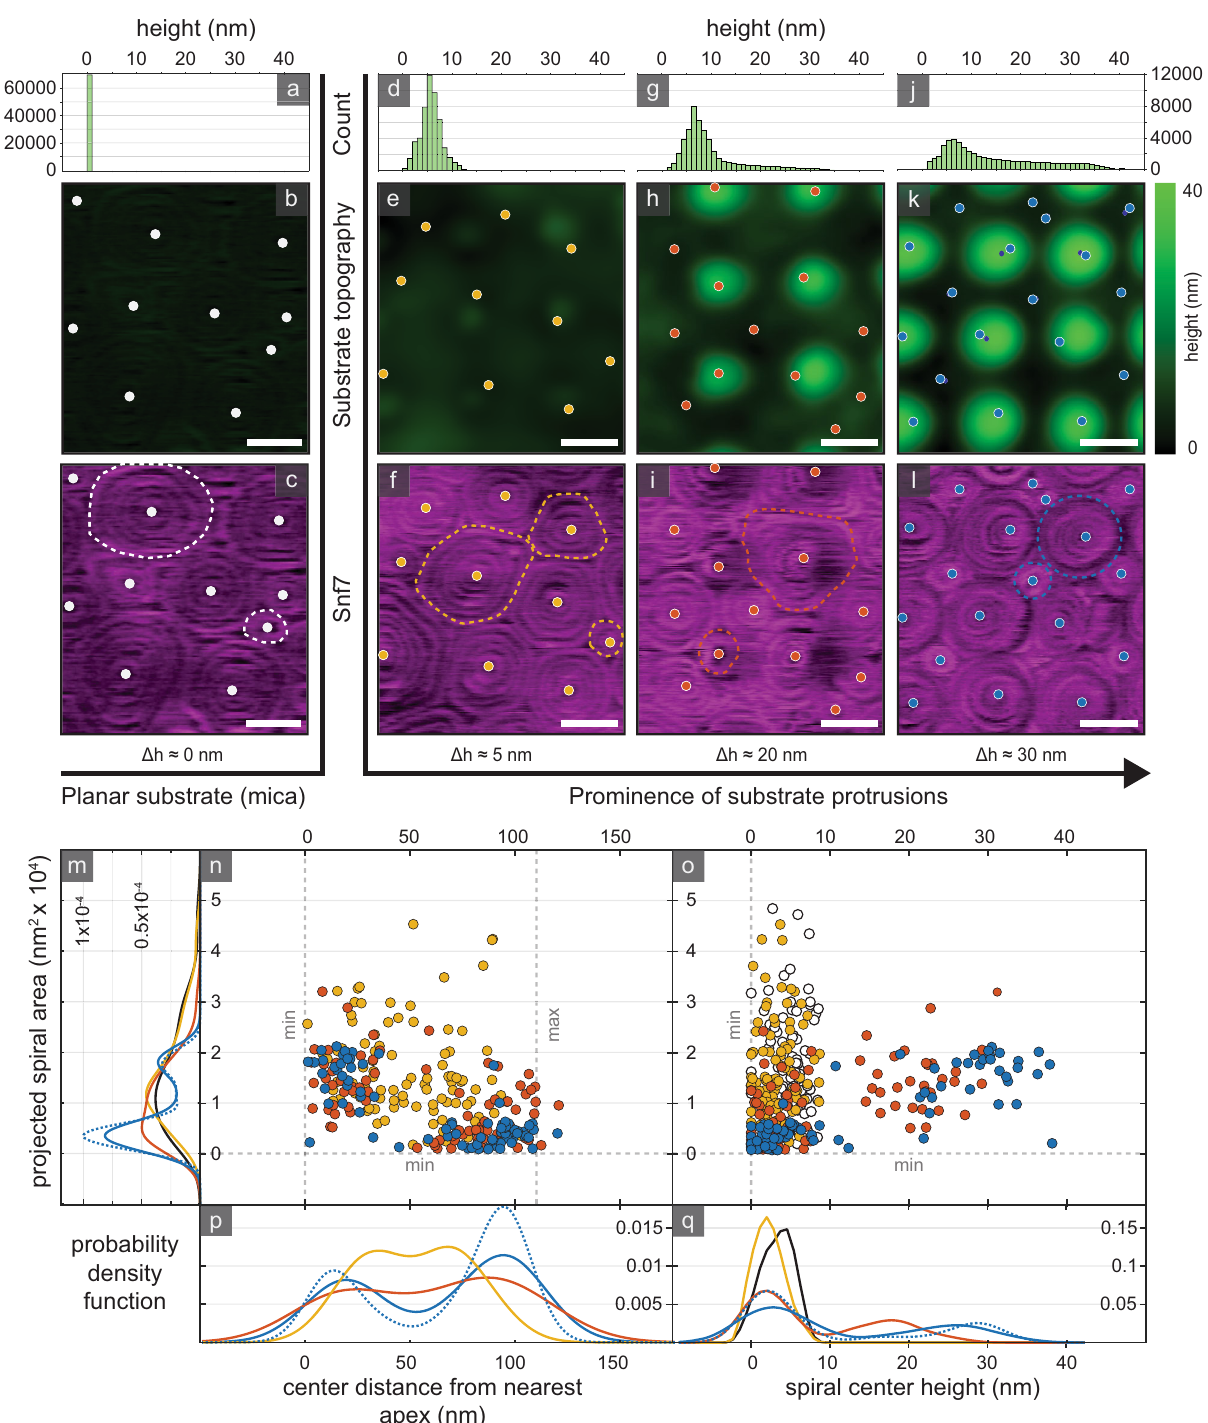
Fig. 3 Snf7 spirals are membrane curvature sensitive. Height distributions of a planar support ( a ) and three different undulated supports ( d , g , j ). Support-channel of planar ( b ) and undulated supports of low ( Δ h ≈ 8 nm, e ), moderate ( Δ h ≈ 25 nm, h ), and prominent ( Δ h ≈ 35 nm, k ) protrusions. ( c , f , i , l ) Protein-channel of Snf7 spirals on substrates ( b , e , h , k ), with representative spirals highlighted (dashed outlines). m Distributions of 2D-projected Snf7 spiral areas. Scatter plots of Snf7 spirals, with 2D-projected area versus spiral center distance from nearest apex ( n ) and versus spiral center height ( o ). Distributions of spiral center distance from nearest apex ( p ), and spiral center height ( q ). White: n = 99 spirals, 5 different imaging areas. Yellow: n = 98 spirals, 5 different imaging areas. Red: n = 80 spirals, 4 different imaging areas. Blue: n = 78 spirals, 5 different imaging areas. Scale bars: 100 nm. Plots ( m – q ) are shown separated by substrate in Supplementary Fig. 3. Source data are provided as a Source Data fi